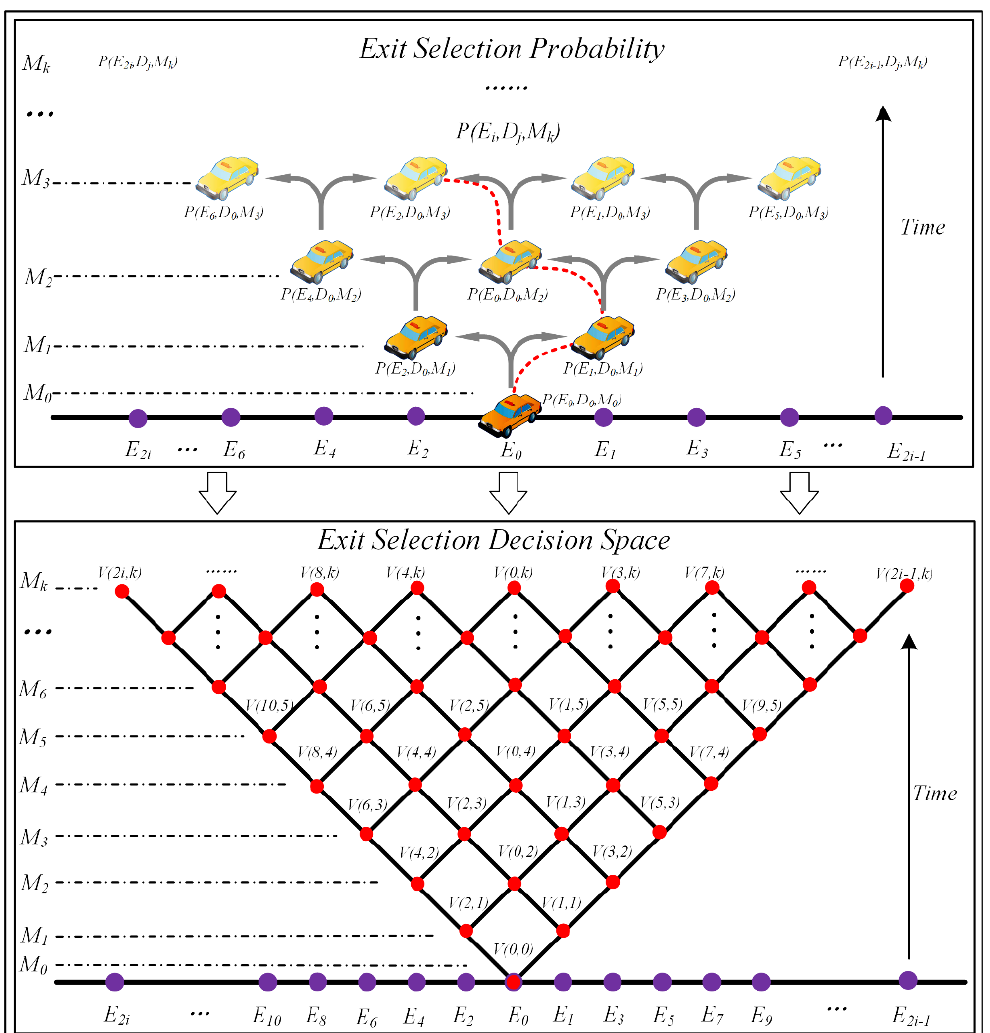
Figure 1. The quantum walk expressway traffic simulation model. Procedure 2: Modeling the probability evolution of exit selection. The dynamics of